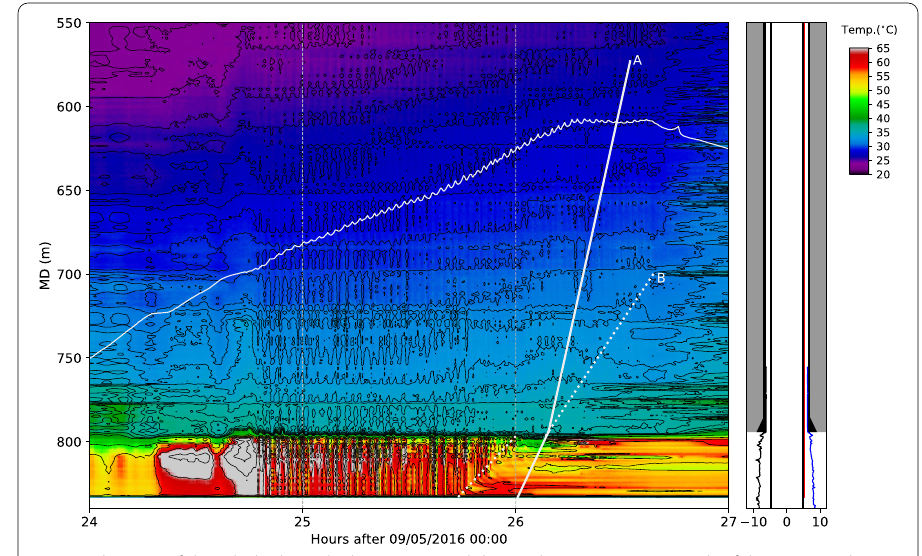
Fig. 6 Close-up of downhole data which was acquired during the reverse cement job of the 9 5/8” and 9 7/8” casing in RN-15/DEEPEGS/IDDP-2. The pressure gauge reading is again displayed in